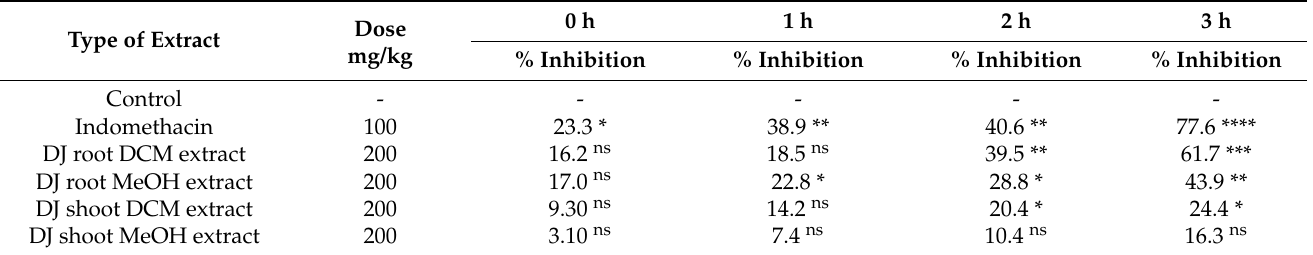
Table 2. Carrageenan-induced edema in rat hind